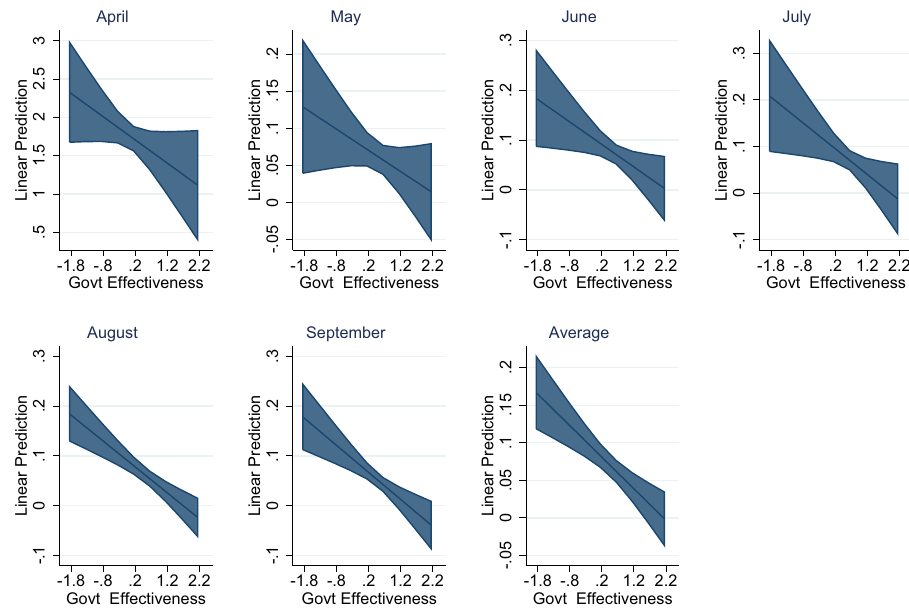
Predicted values of growth rate at different values of govt. effectiveness